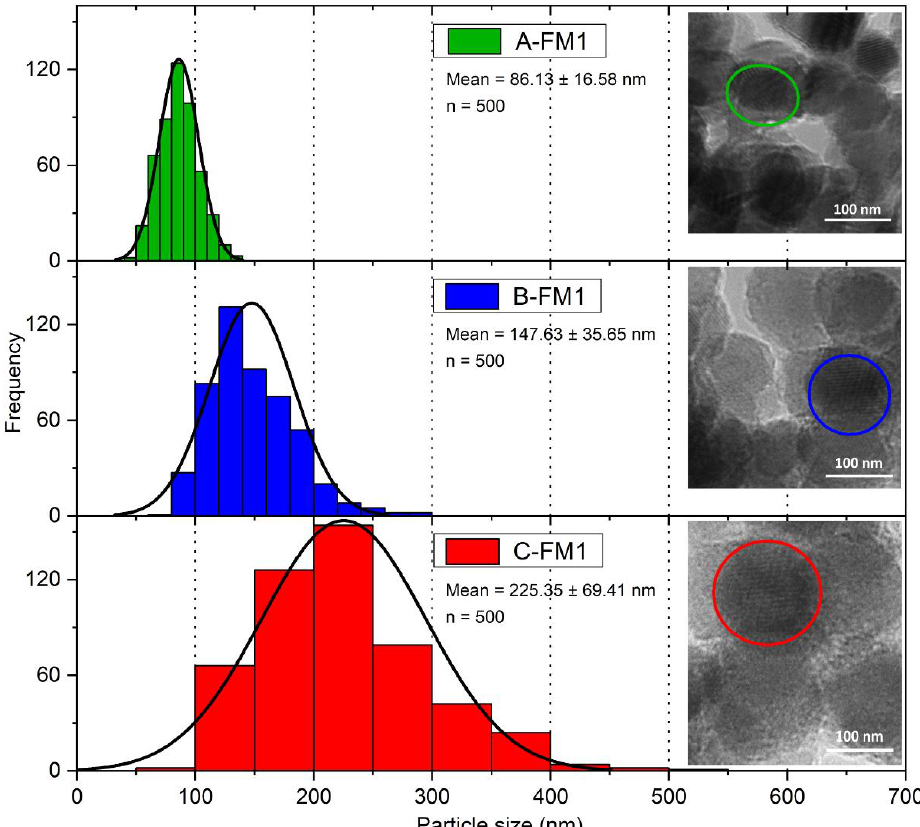
Figure 8. TEM images and size distribution of particles analysis from brand-new TWC, moderately used TWC, and highly used TWC. The enclosed areas correspond to the average measured particle diameter. Variation in size increases as particle grows.